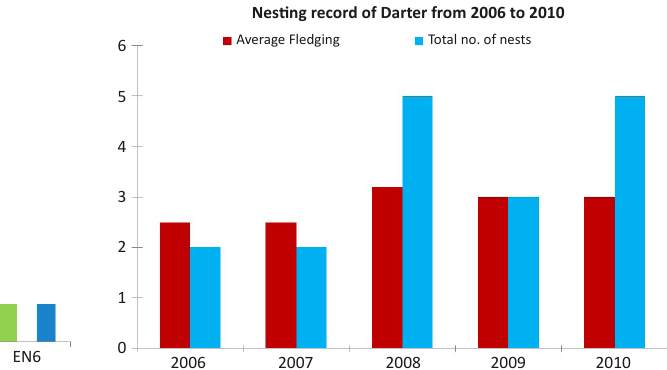
Figure 5. Average and total nests of fledging darter from 2006–2010